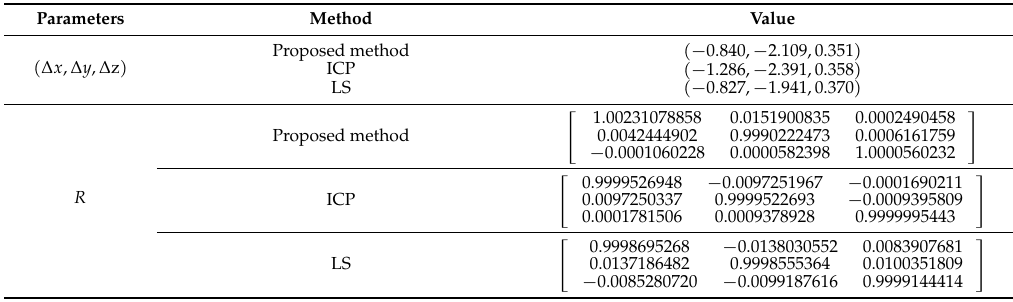
Table 1. Comparison of transformation parameters for the first